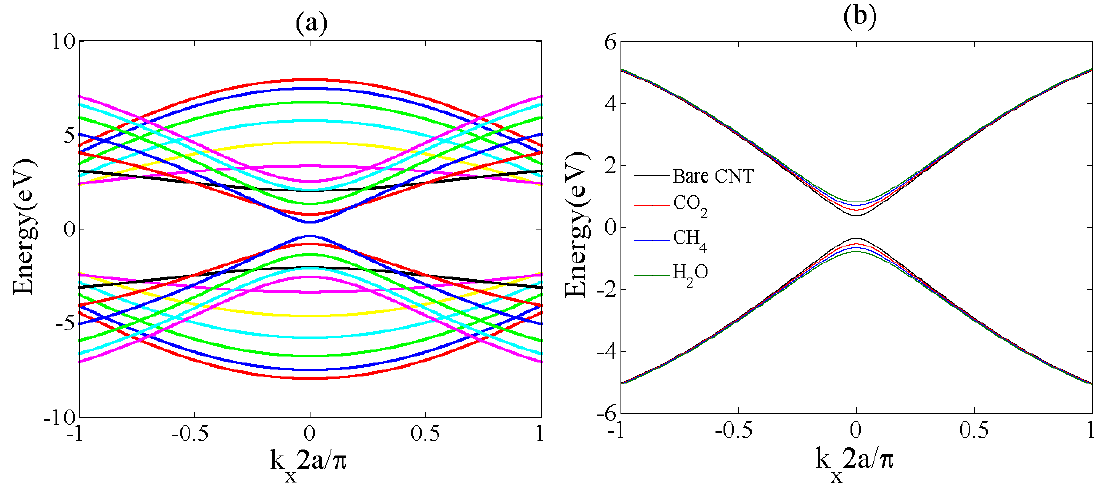
Figure 4. Band structure of ZCNT (13, 0) ( a ) bare ZCNT ( b ) ZCNT in after gas adsorption.